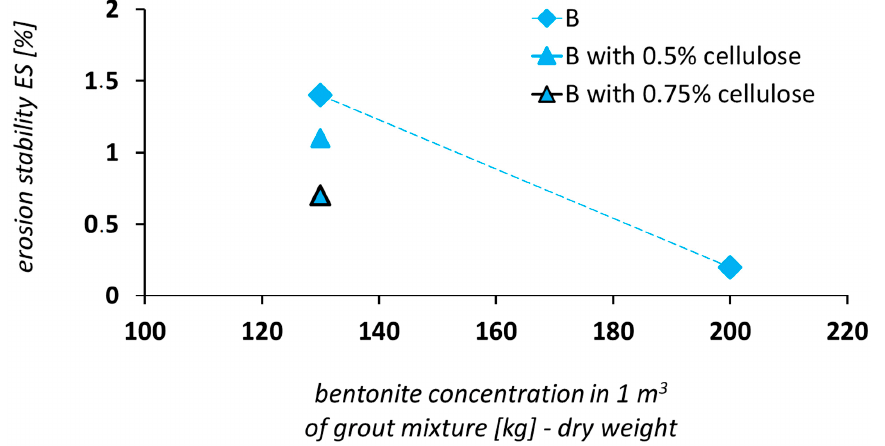
Figure 11. Grout mixture based on Bentonit 75: weight loss of grout mixture (WL) vs. bentonite Figure 11. Weight grout mixture based on Bentonit 75: weight loss of grout mixture (WL) vs. ben- tonite concentration.